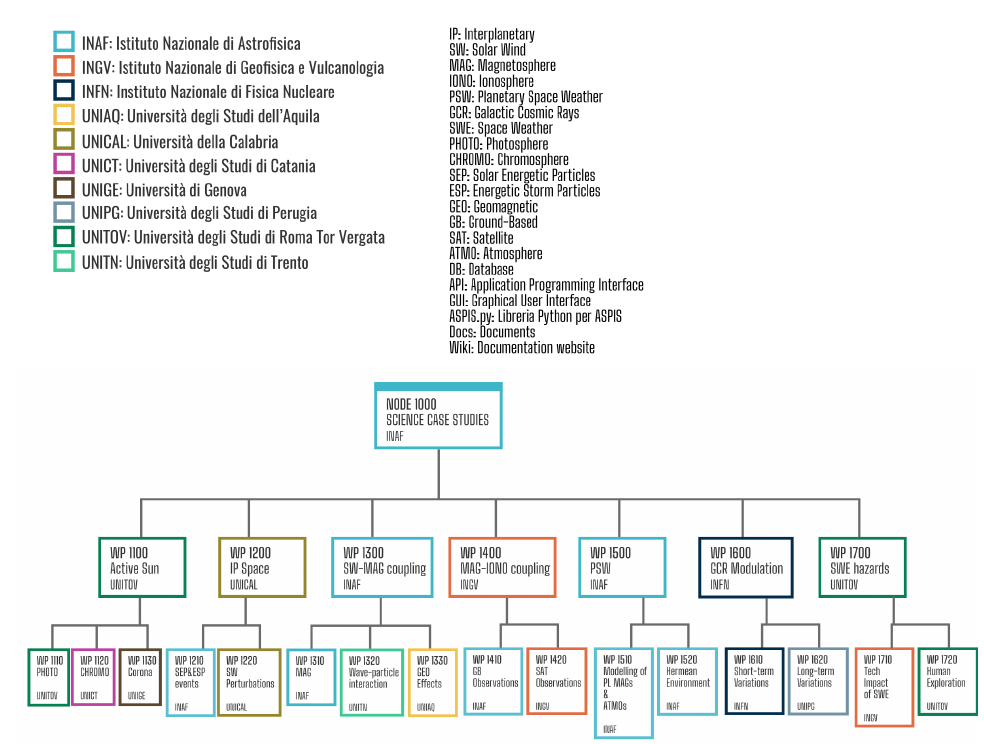
Figure 2. Work breakdown structure of NODE